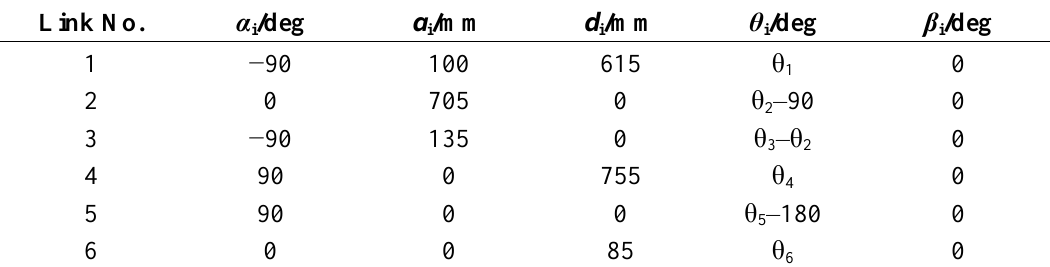
Table 1. Nominal value of kinematic parameters for IRB2400.